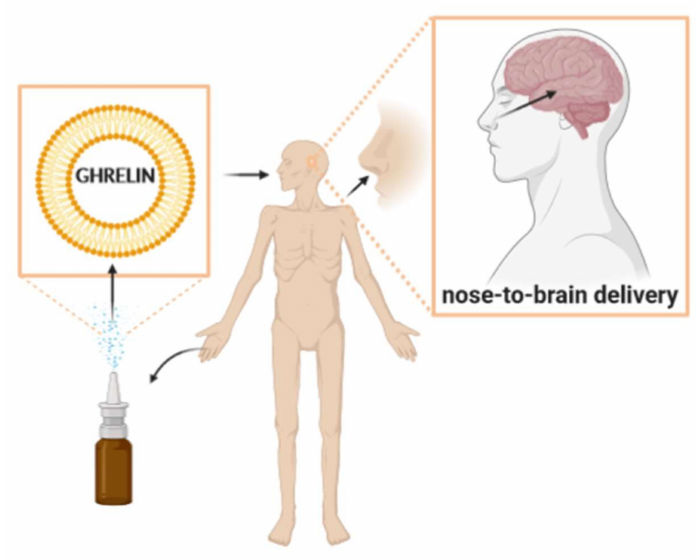
Figure 1. Nose-to-brain delivery of ghrelin-loaded liposomes in cachexia